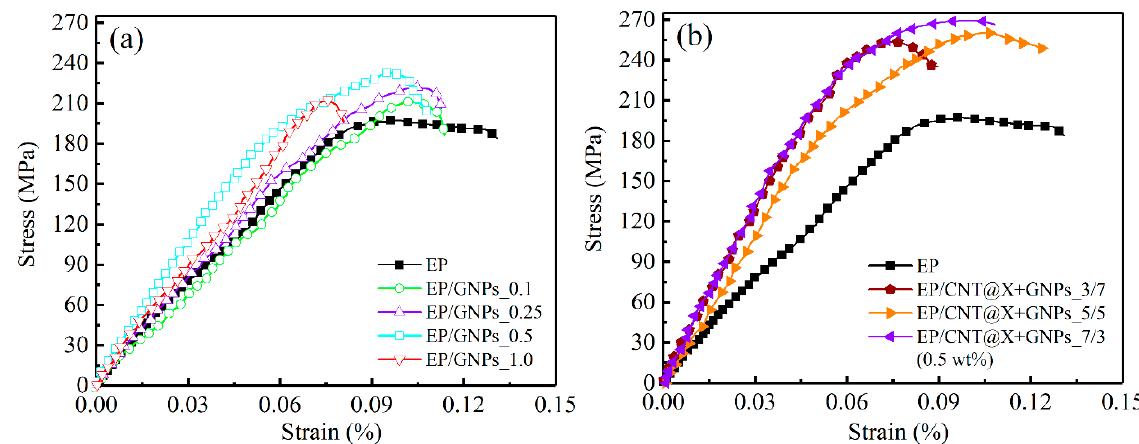
Figure 11. Radar plot for improved ( a ) dynamic compressive strength and ( b ) failure strain with respect to neat epoxy for different nanocomposite systems under a strain rate of 500/s. Figure 12. Dynamic compressive stress–strain curves of the ( a ) EP/GNPs and ( b ) EP/CNT@X+GNPs nanocomposite specimens under a strain rate of 1000/s.